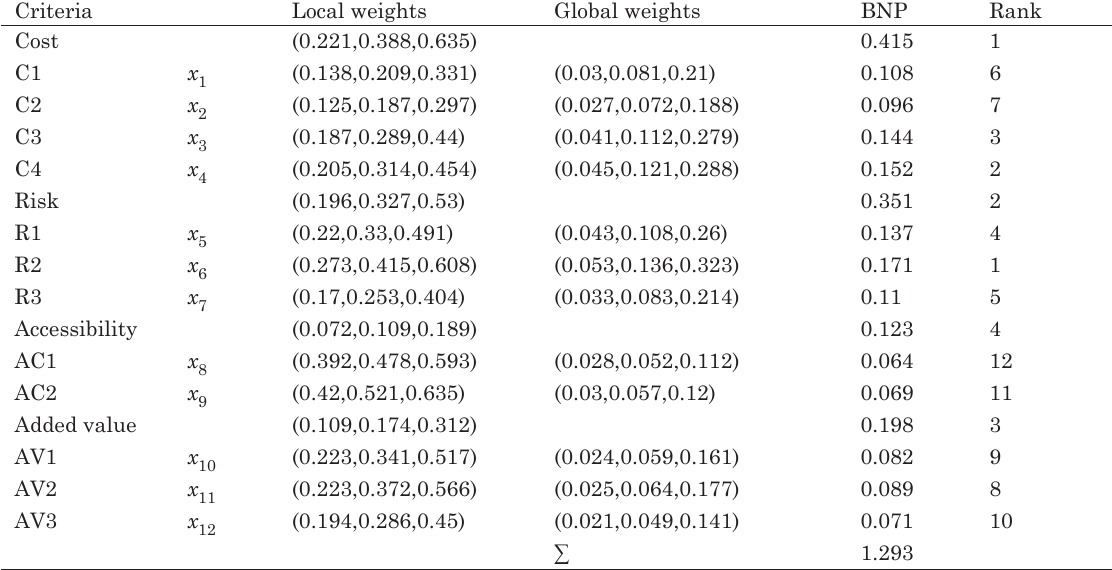
figure 6. The final ranking of the criteria table 2. Fuzzy weights of evaluation criteria by FAHP